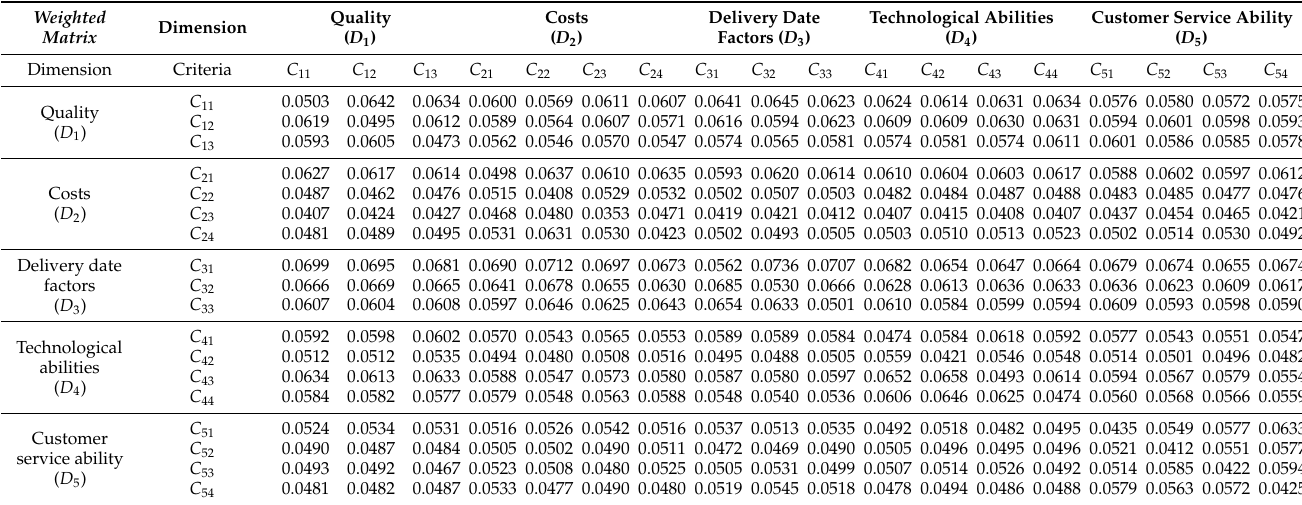
Table 10. The limiting